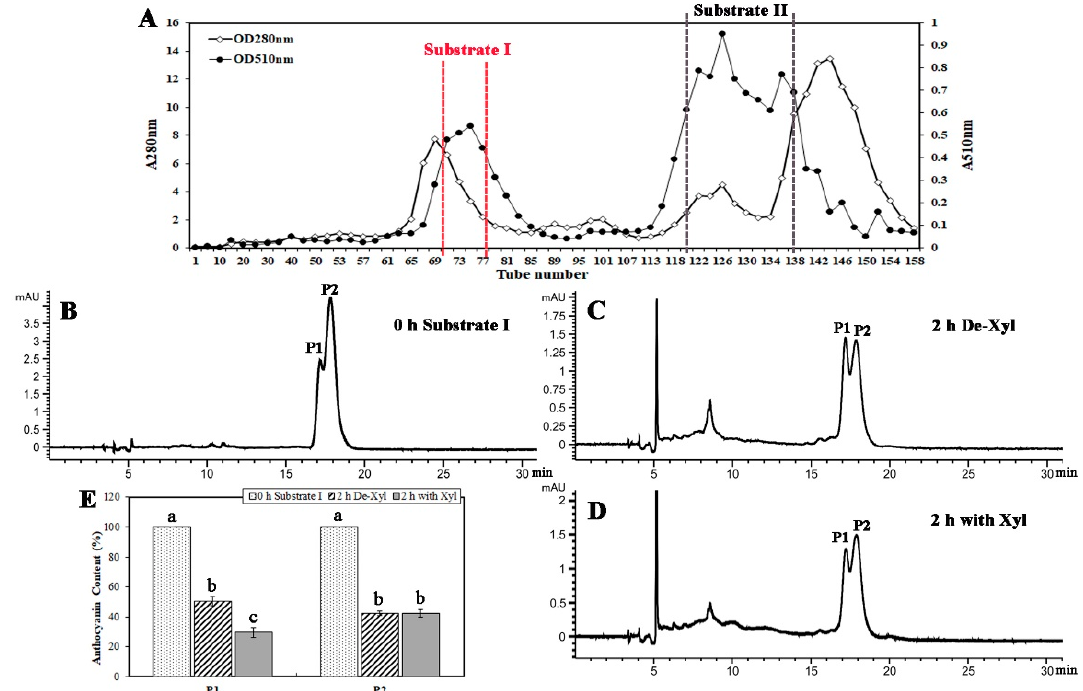
Figure 4. Anthocyanin degradation activity on purified B. calycina anthocyanins by BcXyl. ( A ) B. calycina anthocyanin purification profiles by column chromatography. Absorbance at 510 nm